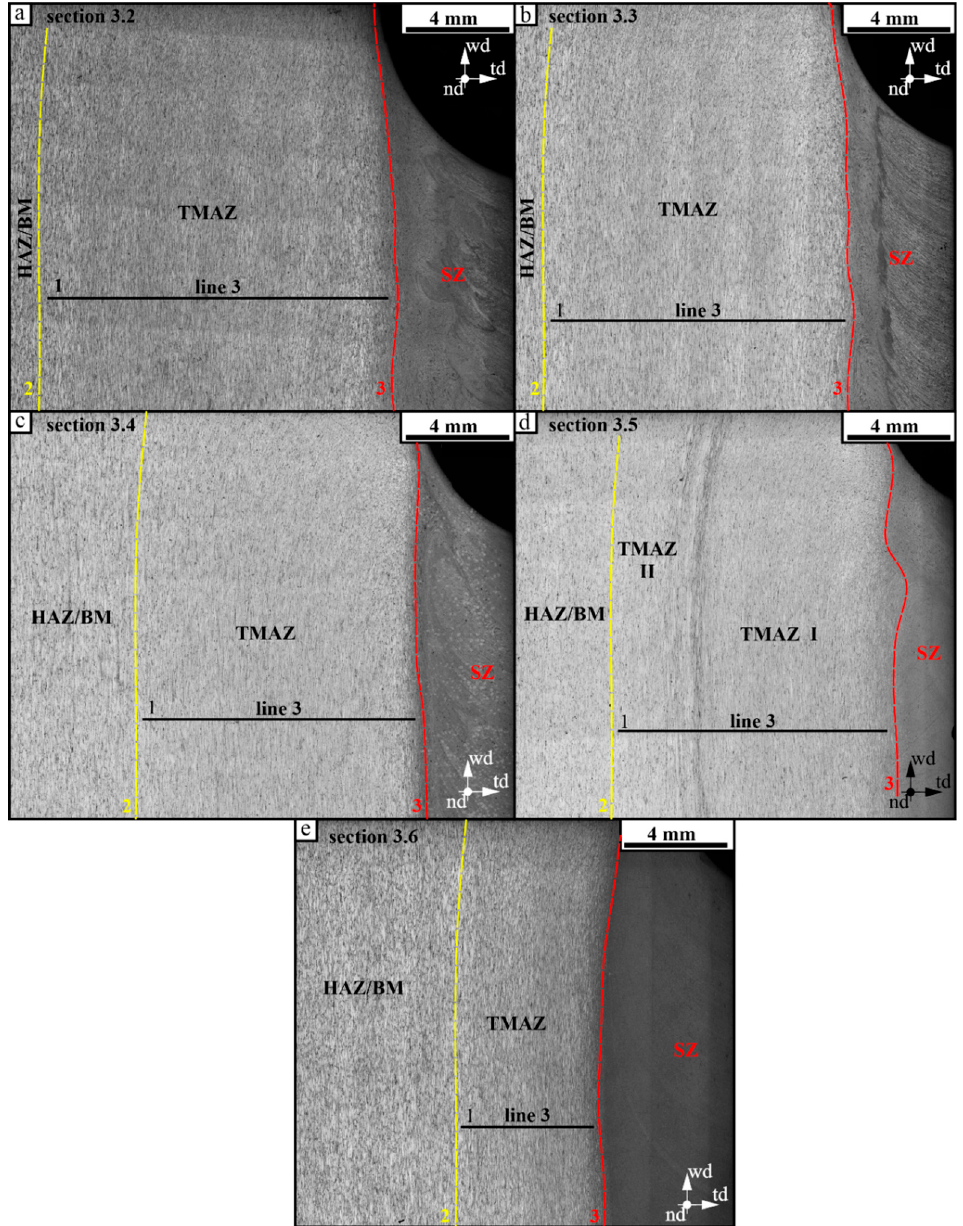
Figure 6. The alloy structures in the exit hole leading edge on the AS side, as viewed in sections 3.2 ( a ), 3.3 ( b ), 3.4 ( c ), 3.5 ( d ) and 3.6 ( e ) (Figure 2).